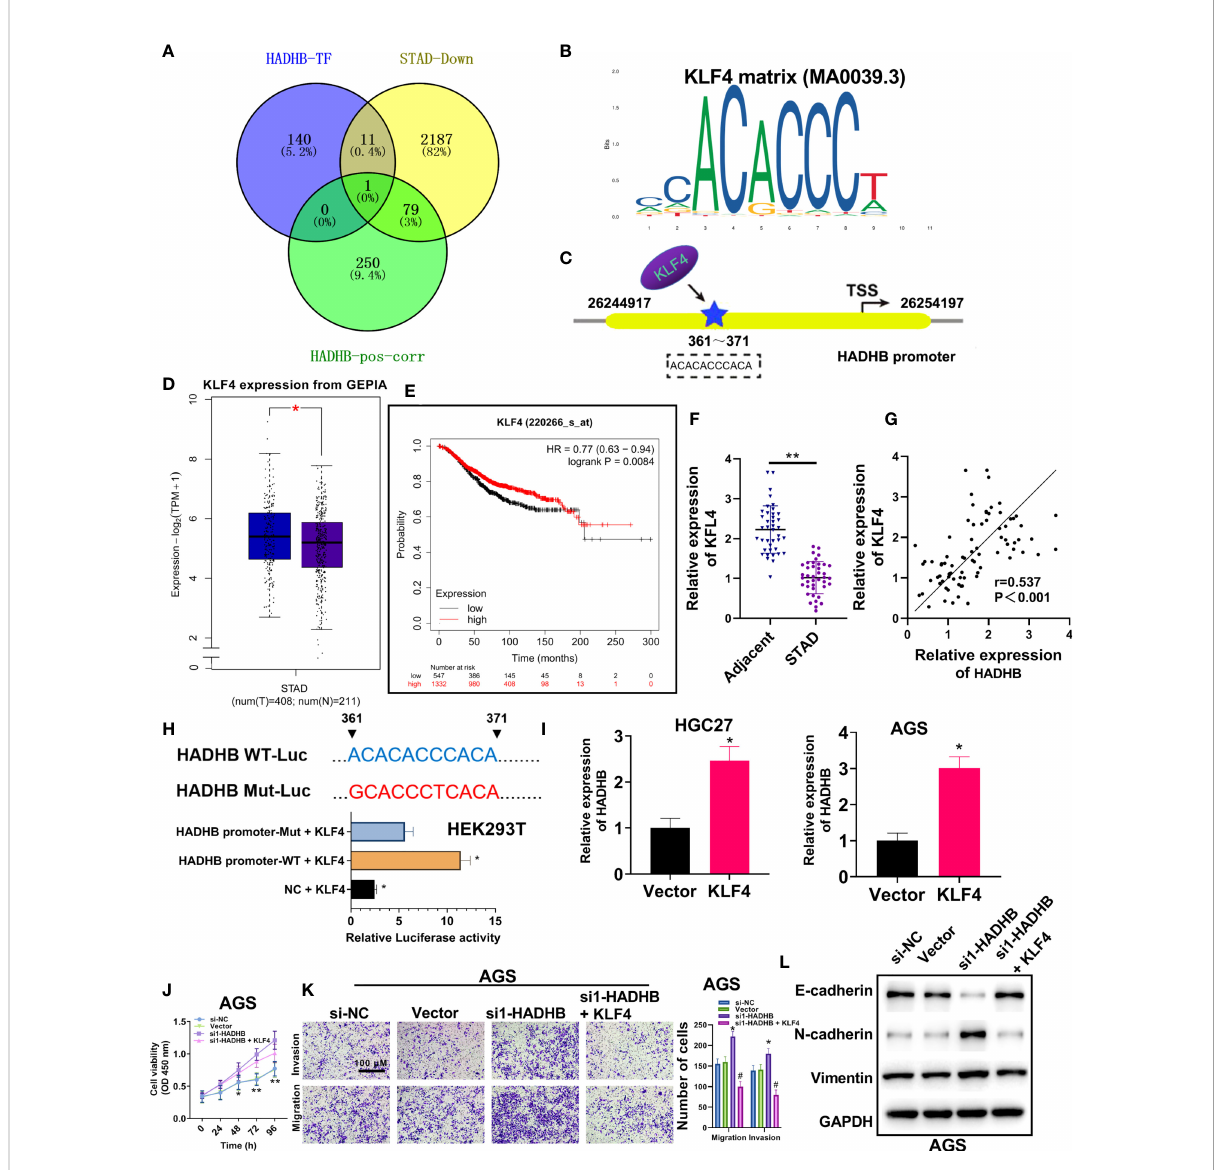
FIGURE 5 Upregulation of KLF4 abolished the HADHB knockdown-induced tumour promoting effects in AGS cells (A) . Venn diagram was generated to screen out the overlapping gene among the three datasets, namely HADHB transcription factor (TF), gastric cancer downregulated genes, and genes positively correlated with HADHB in TCGA. (B, C) . Motif analysis of KLF4 and HADHB promotor binding site analysis was conducted using Jaspar database. (D) . The mRNA expression of KLF4 between normal tissues and tumour tissues in GEPIA. (E) . Overall survival probability of STAD patients was analysed using Kaplan-Meier Plotter (cutoff = 9.01). (F) . KLF4 expression in 40 pairs of clinical STAD tissues was determined using qRT-PCR. (G) . The correlation between HADHB and KLF4 expression in STAD was derived using Pearson correlation analysis. (H) .